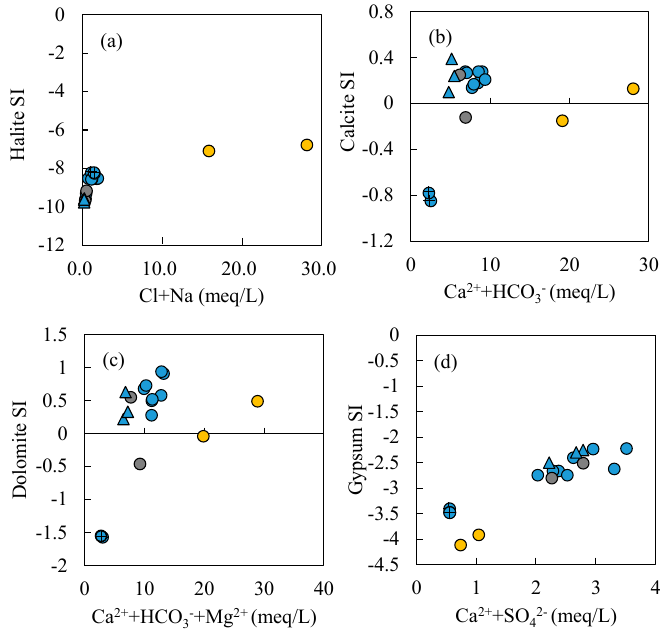
Figure 8. Relationship between ( a ) halite SI and Cl + Na, ( b ) calcite SI and Ca + HCO 3 , ( c ) dolomite SI and Ca + HCO 3 + Mg, and ( d ) gypsum SI and Ca + SO 4 . Triangles are river samples, circles are groundwater samples, and circles with a cross are the water samples at the borehole ZK. Yellow c represents the spring at Zhanggu, grey represents the spring at Kemu, and blue represents the